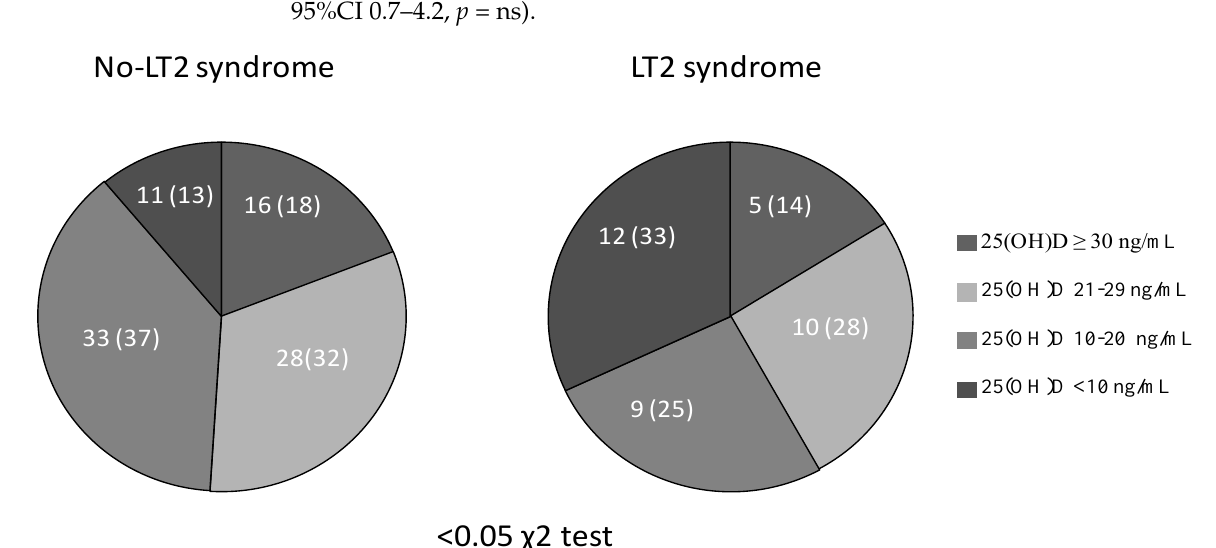
Figure 1. The percentage of subjects with 25(OH)D deficiency in patients with and without low T3 syndrome.